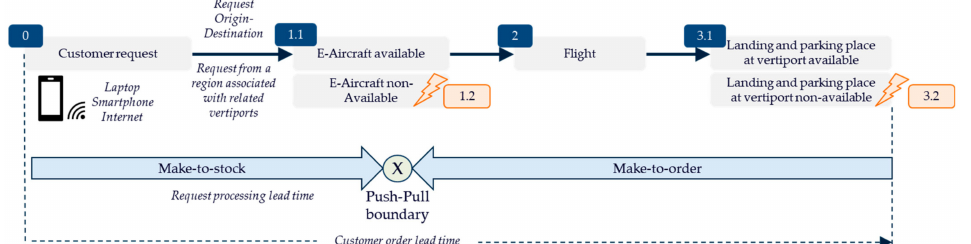
Figure 9. Customer Request Processing: Push-pull boundary and non-availability of aircraft and